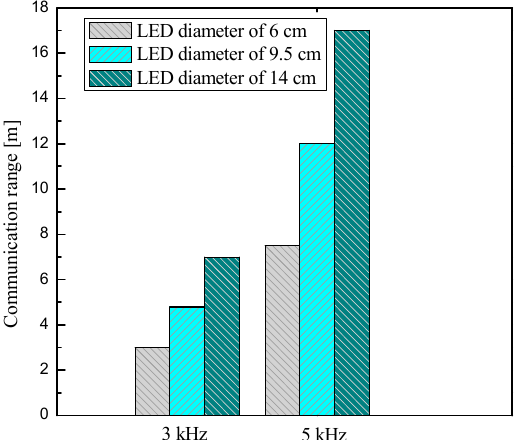
Figure 8. Variation in the number of strips with communication range for a CMOS camera at a transmitted bit frequency of ( a ) 3 kHz, and ( b ) 5 kHz.